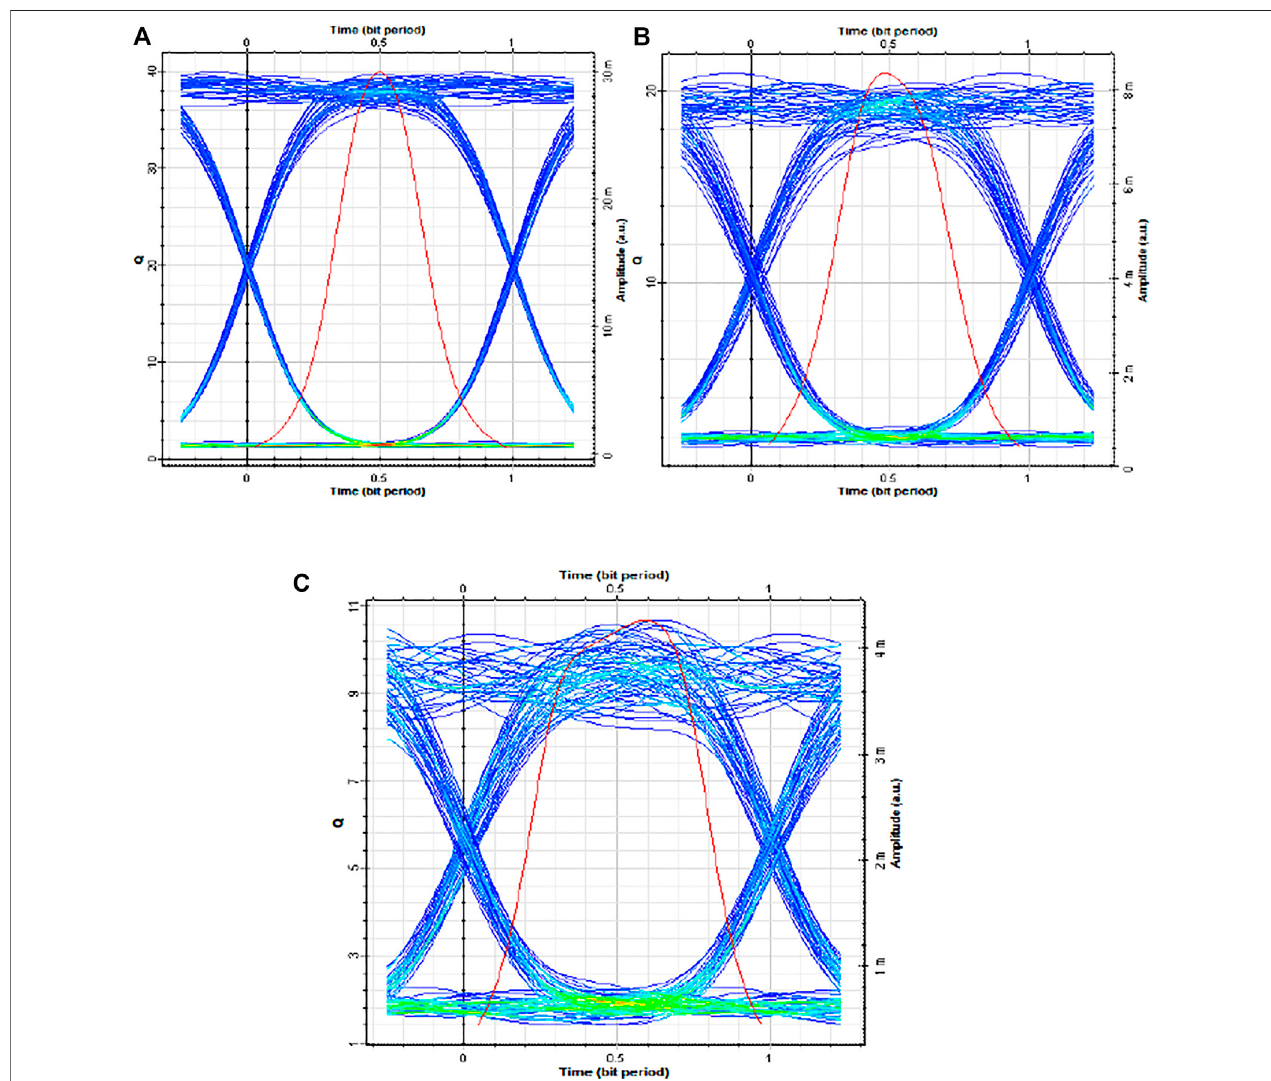
FIGURE 8 | Eye diagrams of designed FSO system at a link range of 3 km for beam divergence of (A) 2 mrad (B) 4 mrad (C) 6 mrad.